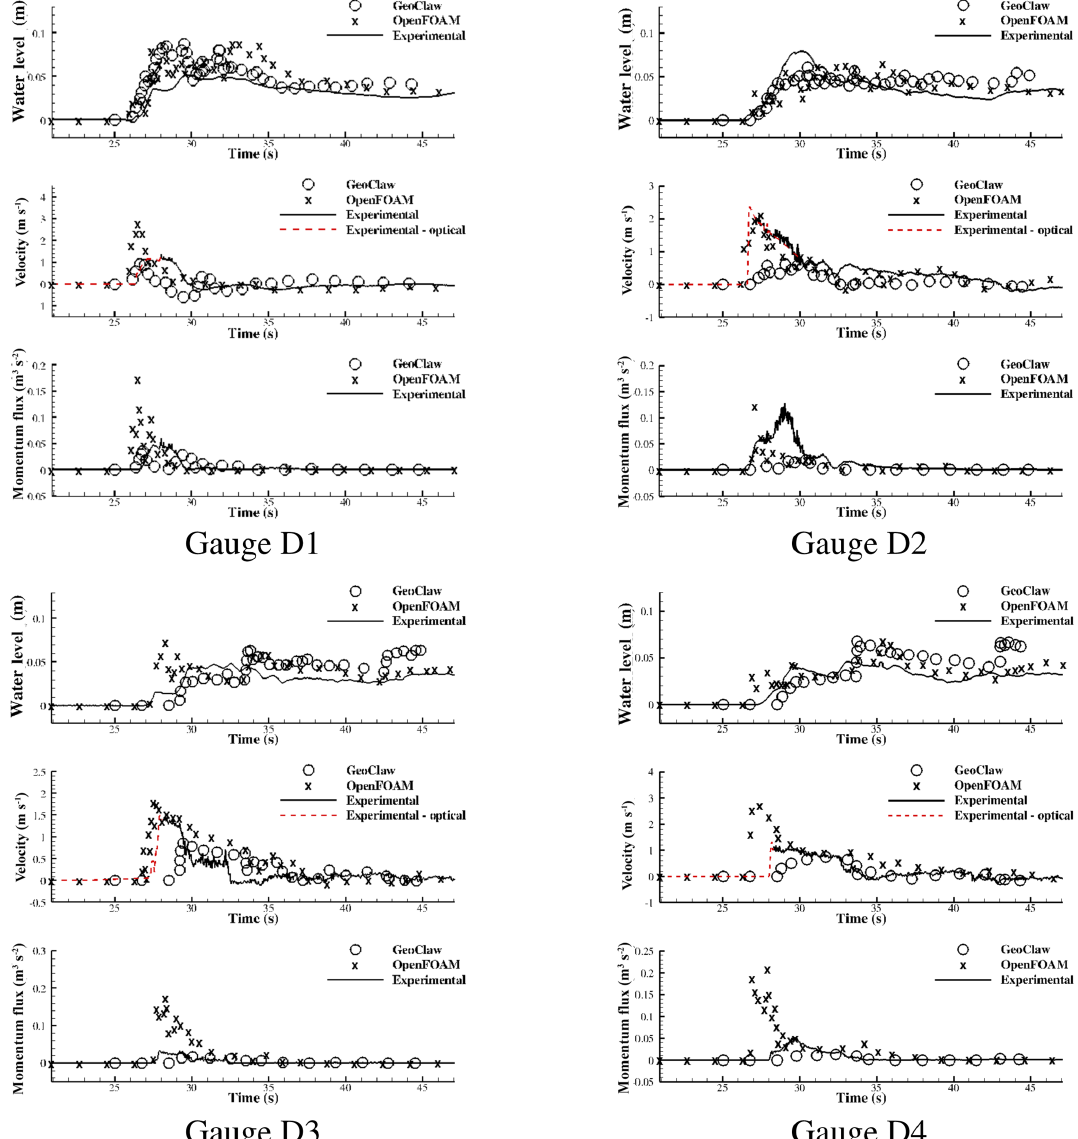
Figure 11. Time histories of surface elevation, cross-shore velocity, and momentum flux at some selected gauges in group